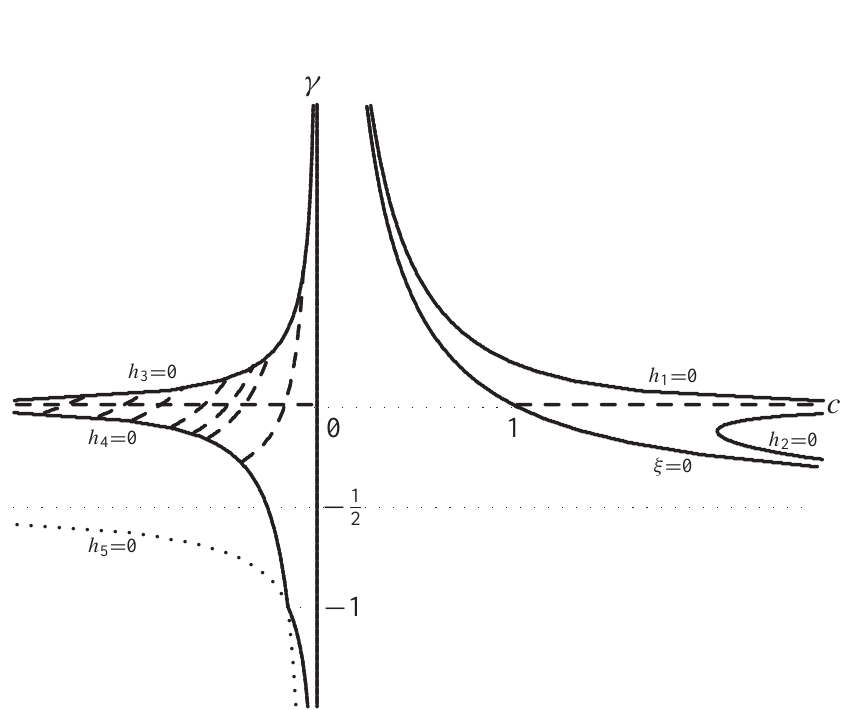
Fig. 3 – Any pair (c, γ ) , in each of the two connected components, generates a complete linear Weingarten surface and it is cmc when γ = 0. (c, γ ) on the dashed curves in the left region generate 1-periodic n -bubble surfaces with two ends of geometric index m